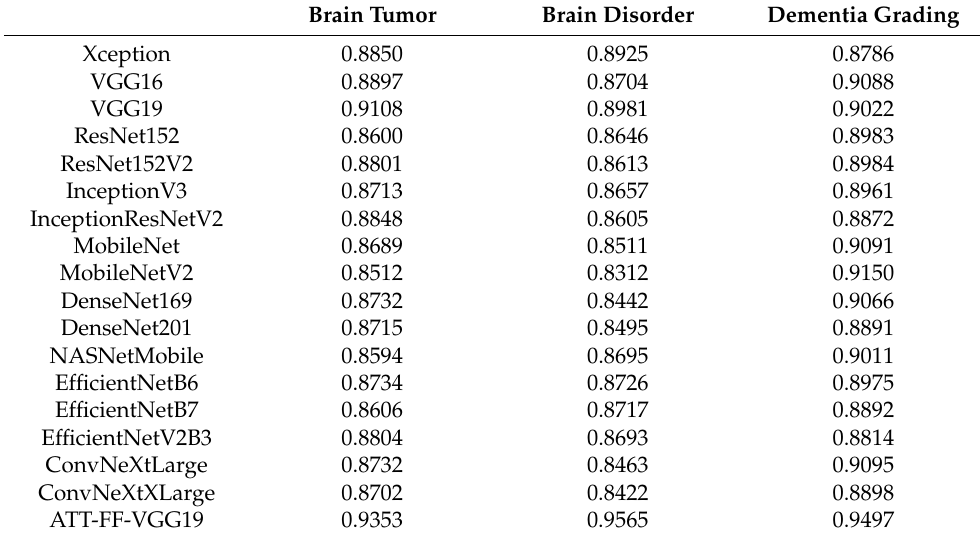
Table 5. Accuracy of 17 state-of-the-art networks on the three datasets of the study. Brain Tumor Brain Disorder